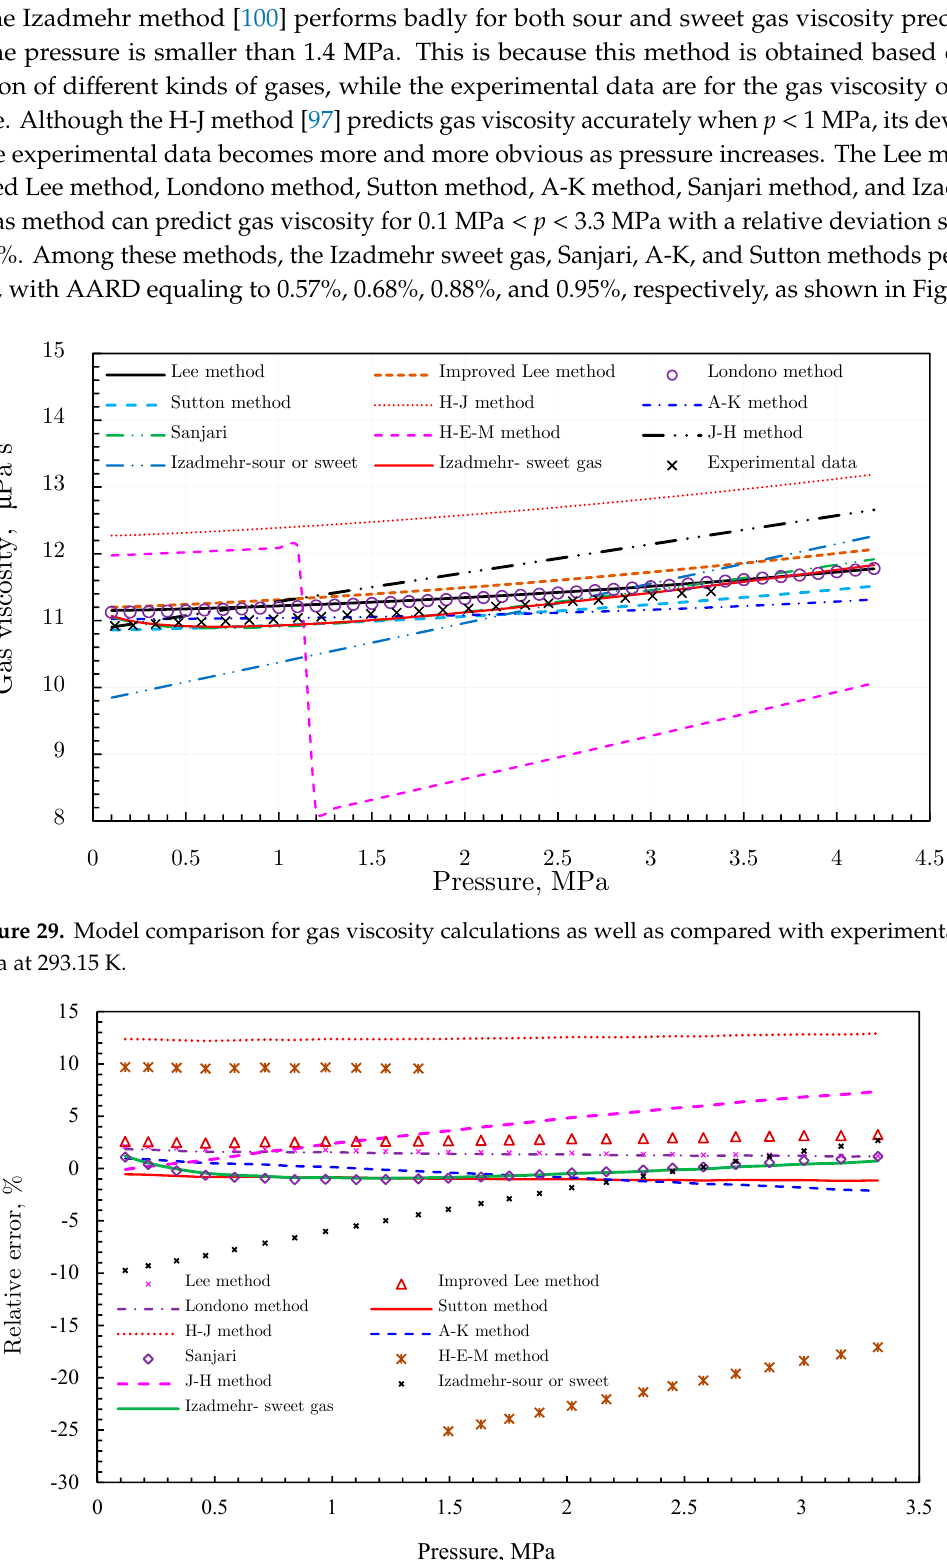
Figure 30. Relative deviation of different models for gas viscosity calculation at 293.15 K.